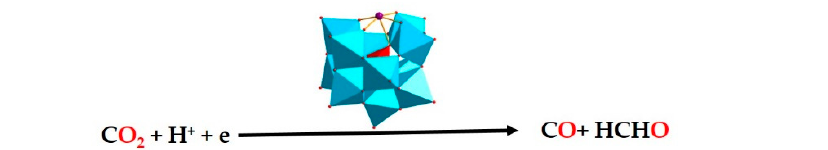
Figure 11. Electroreduction of CO 2 by [SiW 11 O 39 Co] 6 − catalyst. Color code: WO 6 octahedron, light blue; SiO 4 tetrahedron, red; Co, purple ball; O, red ball. The notation of (_) in the above figure represents a vacant coordination site.